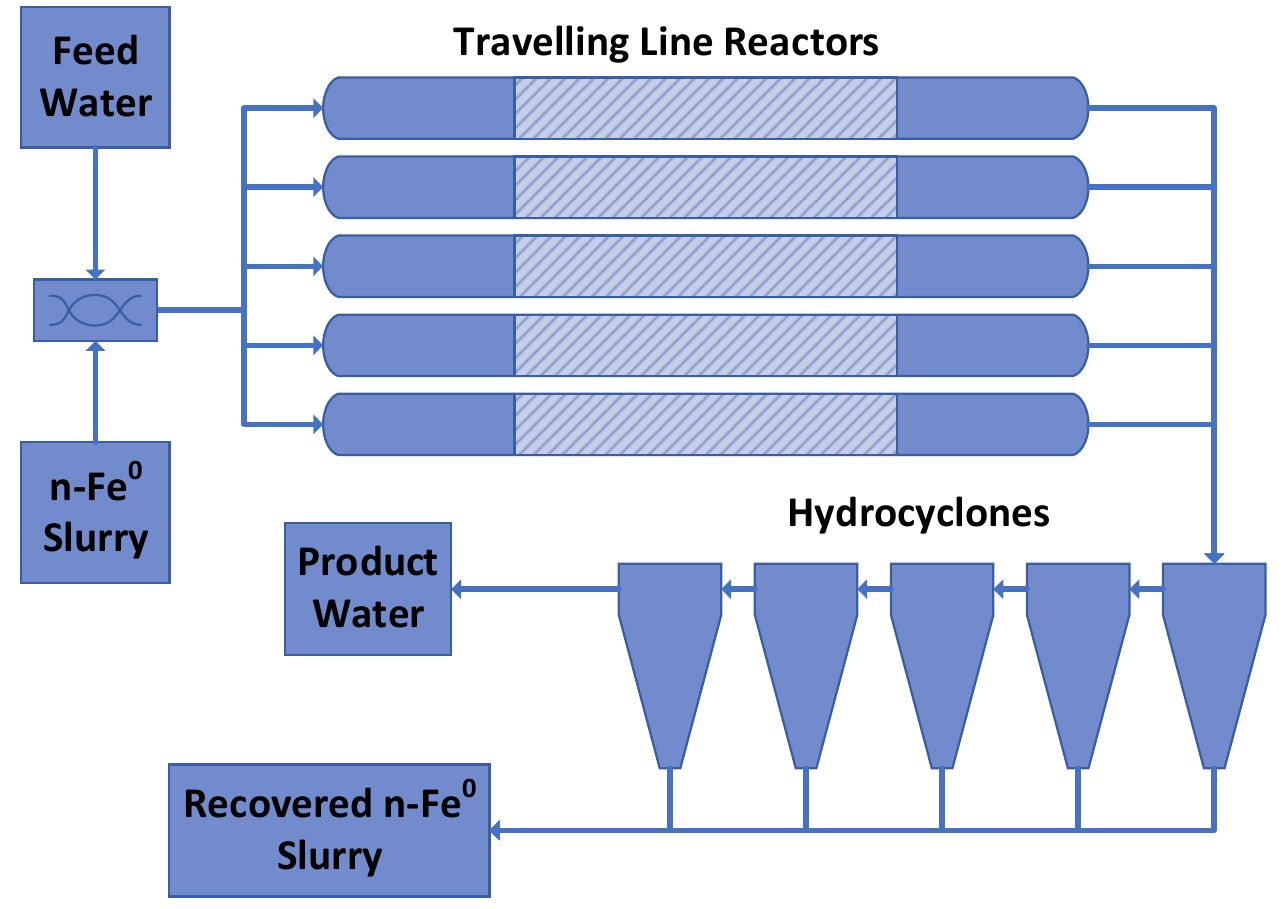
Figure A28. Example process flow for a traveling line reactor train complex, using entrained n-Fe 0 , processing 40 m 3 h − 1 .